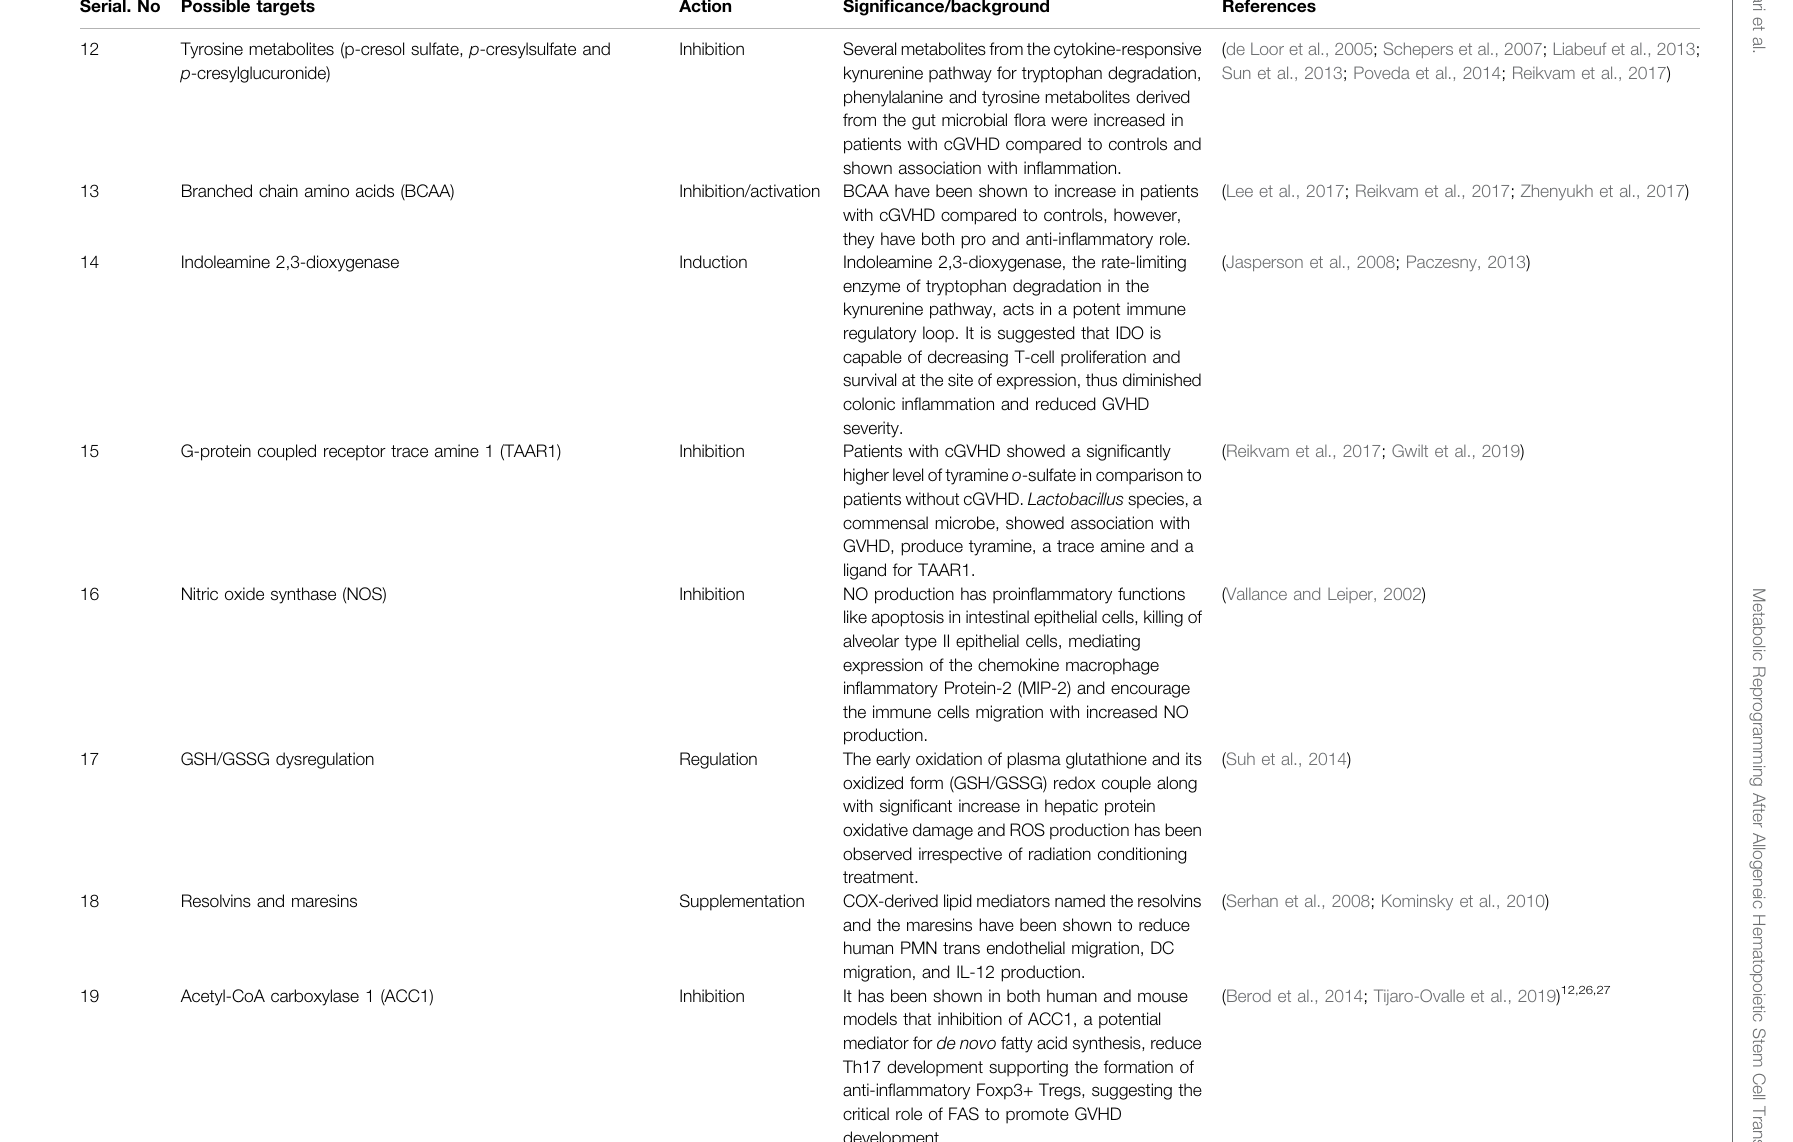
TABLE 1 | ( Continued ) Possible potential therapeutic targets used in past or worth to try in future.